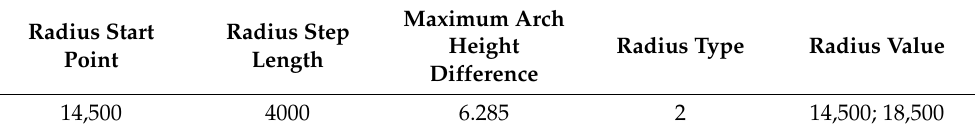
Table 1. Optimization results of the two-span and one-break main curved keel.